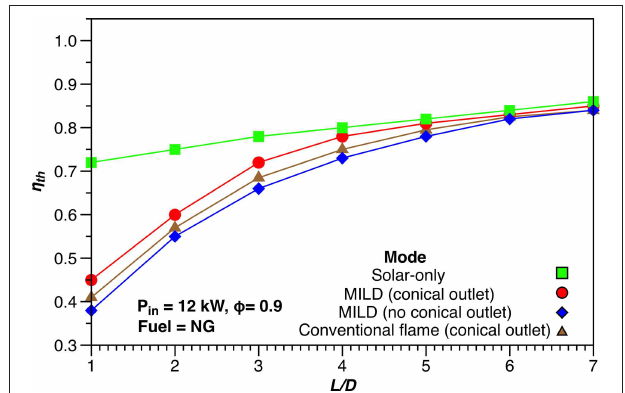
FIGURE 4 | Calculated values of the recirculation rate factor, Kv, along the x-axis of the device, by varying the azimuthal angle ( β ) of the air jets, and for a fixed value of the air jet inclination angle ( α ). The case refers to MILD operations (fuel = NG) with L/D = 3 and a conical